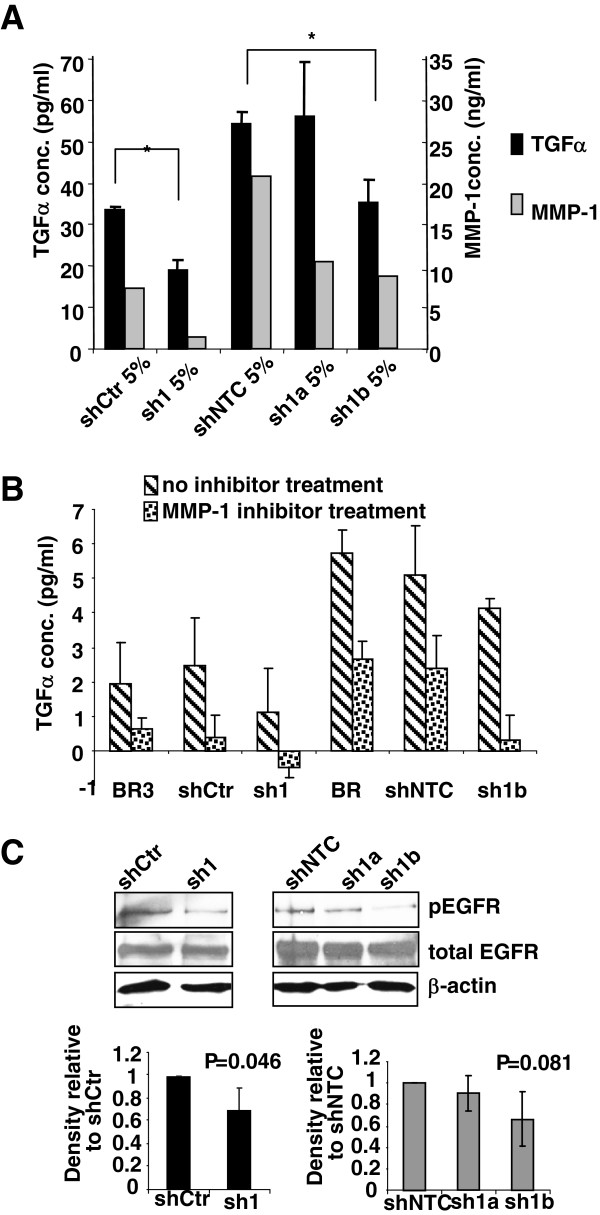
Stable knockdown of MMP-1 is associated with reduced TGFα in culture supernatants. A, MMP-1 and TGFα protein levels in conditioned media were measured by ELISA. Cells were cultured in MEM with 5% FBS to 80% confluence. Supernatants were separated and concentrated, and MMP-1 and TGFα protein concentrations were measured by ELISA. Asterisks indicate significant differences (P < 0.05) in TGFα in culture supernatants from control shRNA expressing cells compared with MMP-1 shRNA expressing cells. This data shown are representative of 3 independent experiments. B, TGFα concentrations in conditioned media were measured by ELISA after 24 h incubation with MMP-1 inhibitor at 2 μM, in serum free medium. This data shown are representative of 3 independent experiments. C, Immunoblotting for phospho-EGFR, total EGFR and β-actin protein levels in each cell line cultured in culture medium with 5% FBS. This experiment was performed in triplicate.